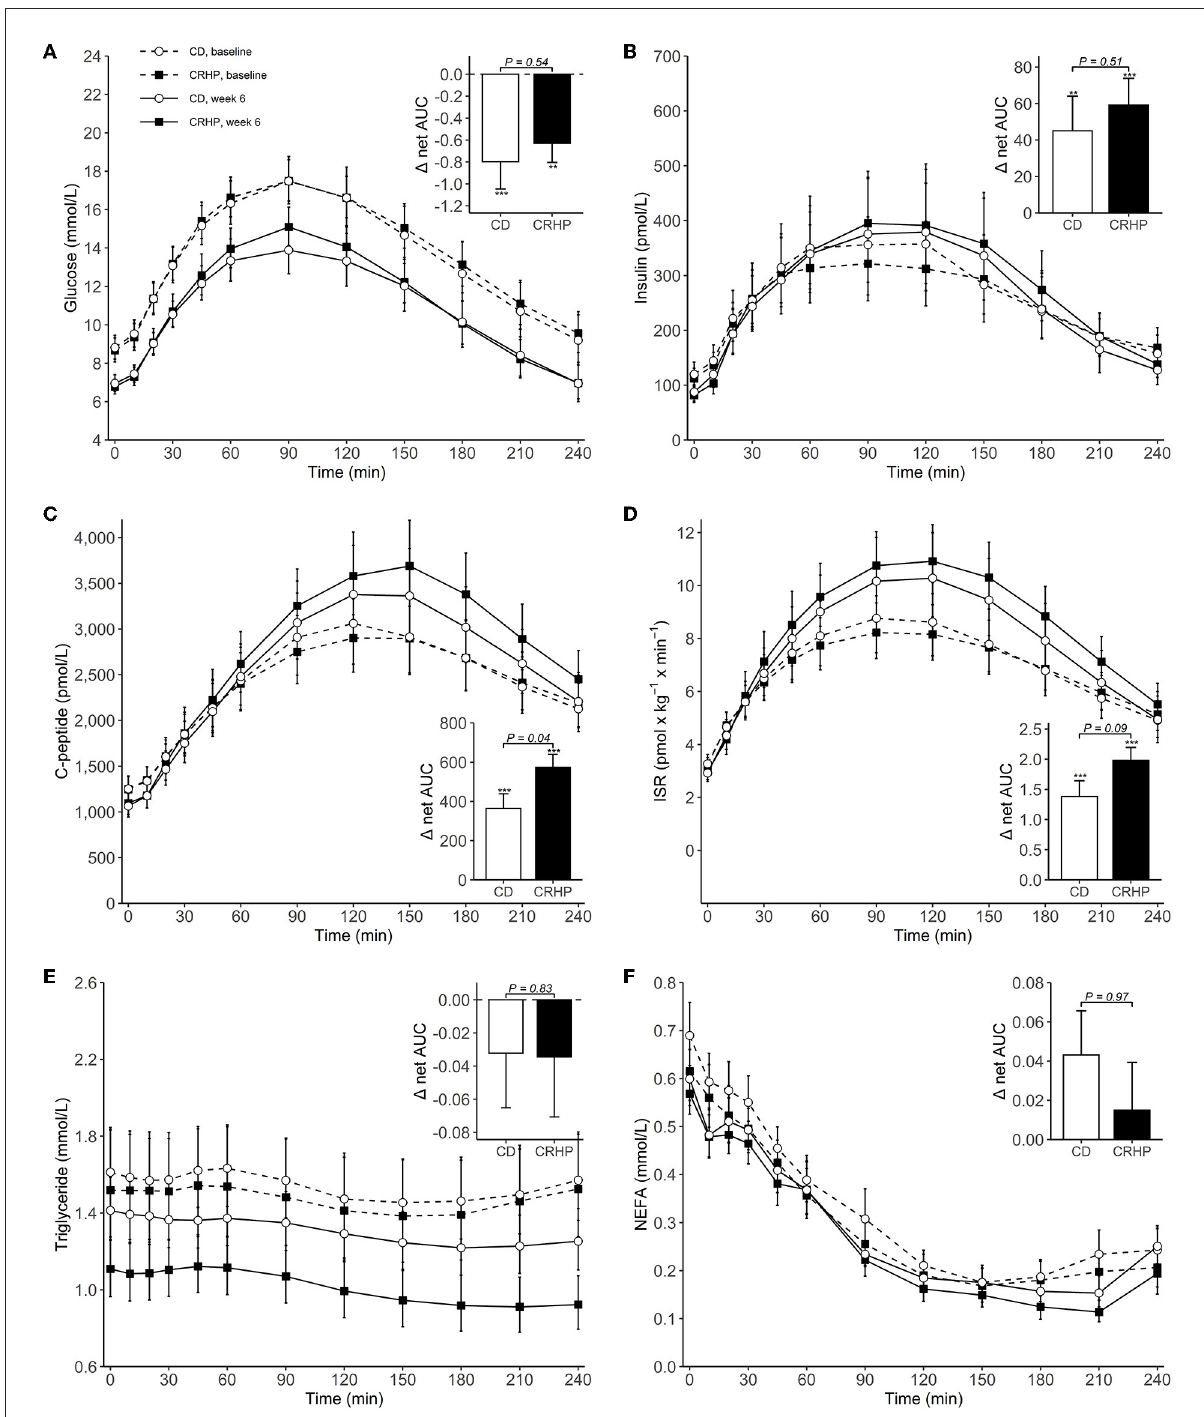
FIGURE1 Concentrations of plasma glucose (A) , serum insulin (B) , serum C-peptide (C) , insulin secretion rate (ISR) (D) , serum triglyceride (E) , and serum non-esterified fatty acids (NEFAs) (F) during an OGTT at baseline and after 6 weeks of a CD or CRHP diet. Inserted plots represent net AUC in the units stated x 240min. Data are presented as mean ( SEM) following log-transformation, except for net AUCs; ** P < 0.01; *** P < ±